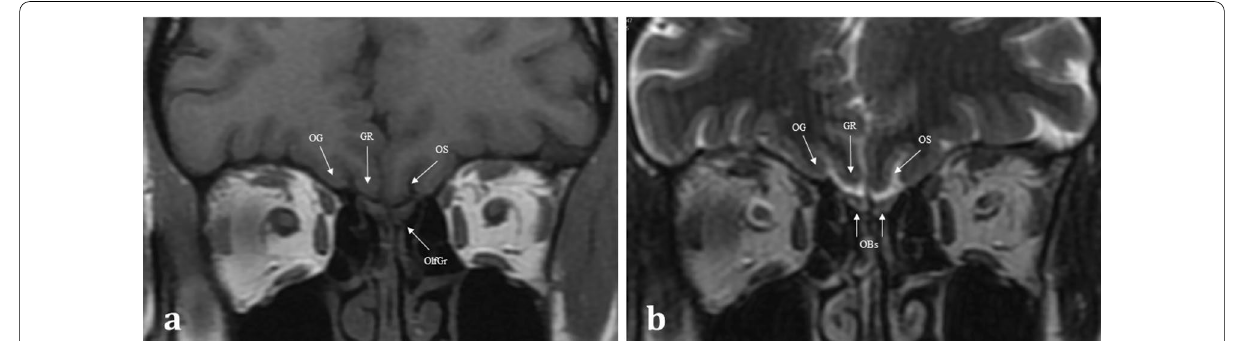
Fig. 1 Normal Anatomy. Coronal T1WI ( a ) and T2WI ( b ) MRI images of the normal location and appearances of the olfactory bulbs (OBs). These lie within the olfactory grooves (OlfGr) of the anterior cranial fossa. Notice how the olfactory bulbs are surrounded by T2 hyperintense CSF. The olfactory tracts (not shown) are a posterior continuation of the olfactory bulbs and run within the olfactory sulci (OS). The olfactory sulcus is lateral to the gyrus rectus (GR) and medial to the orbital gyrus (OG)